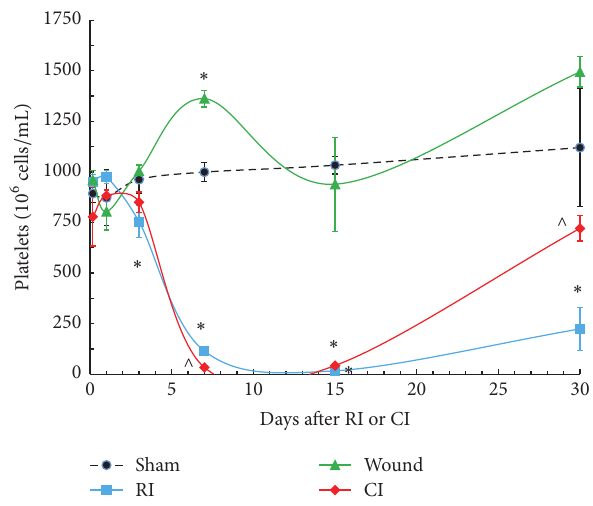
Figure 1: Numbers of platelets were depleted in the first 7 days after RI and CI and then partially recovered gradually between days 15 and 30. Platelet numbers at 4-5h and days 1, 3, 7, 15, and 30 in surviving sham, wounded, RI, and CI mice without Alxn4100TPO treatment. 𝑁 = 6 per group. Data are presented as mean ± SEM. ∗ 𝑝 < 0.05 versus sham; ∧ 𝑝 < 0.05 versus RI. CON: control; RI: 9.5 Gy; CI: 9.5 Gy and skin